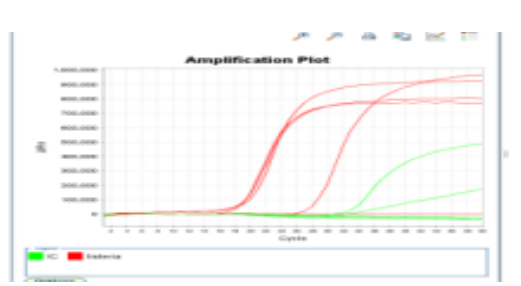
Figure (5): comparison between percentages of restaurants with salads contaminated with listeria spp. & other not contaminated.